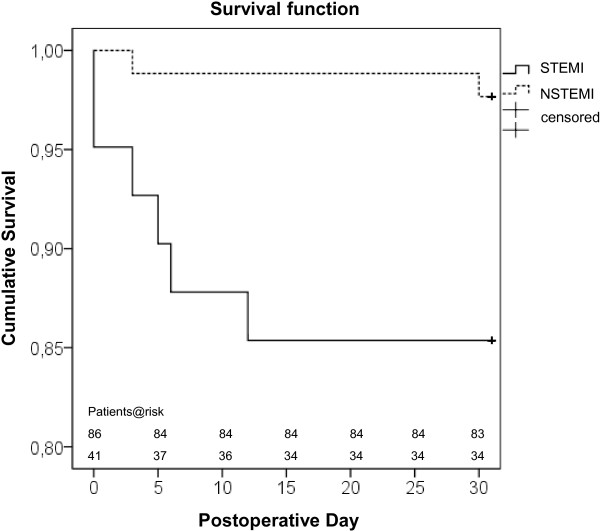
Kaplan-Meier Survival function, subdivided into NSTEMI and STEMI patients for the first 30 postoperative days.